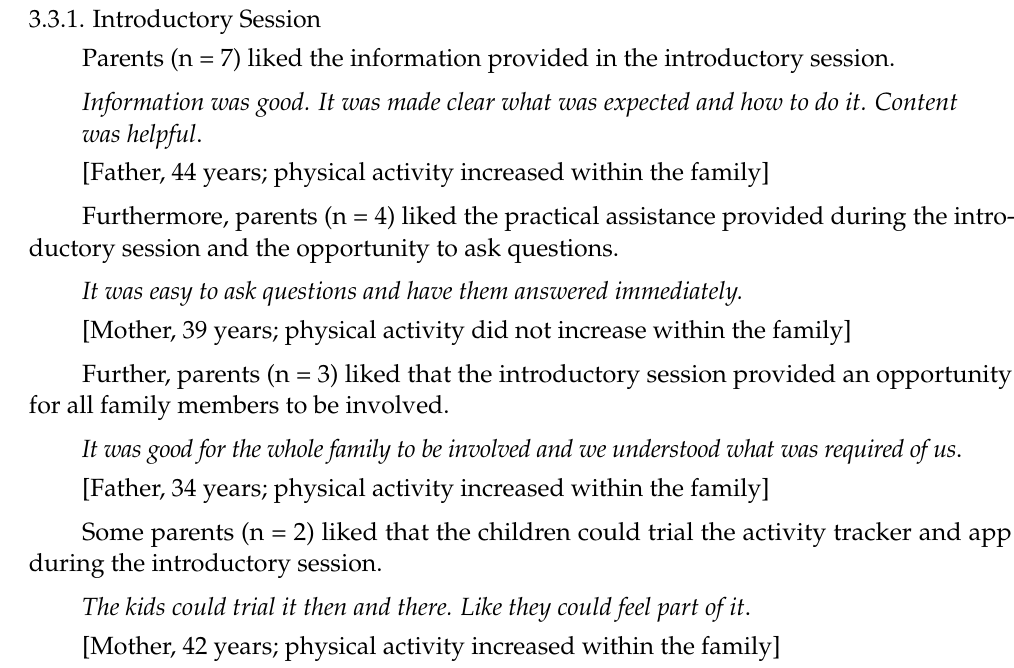
Figure 2. Families’ satisfaction with the Step it Up Family intervention components.